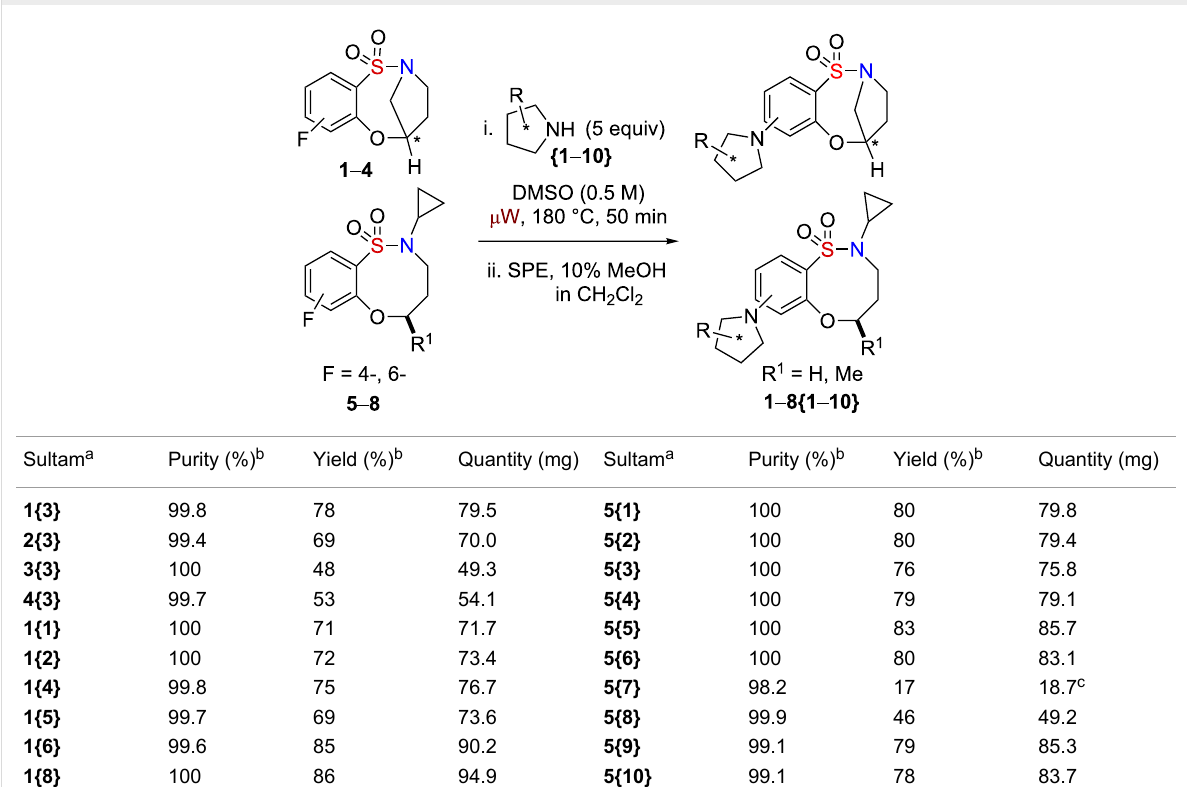
Table 2: Use of a 20-member validation library to probe the reaction